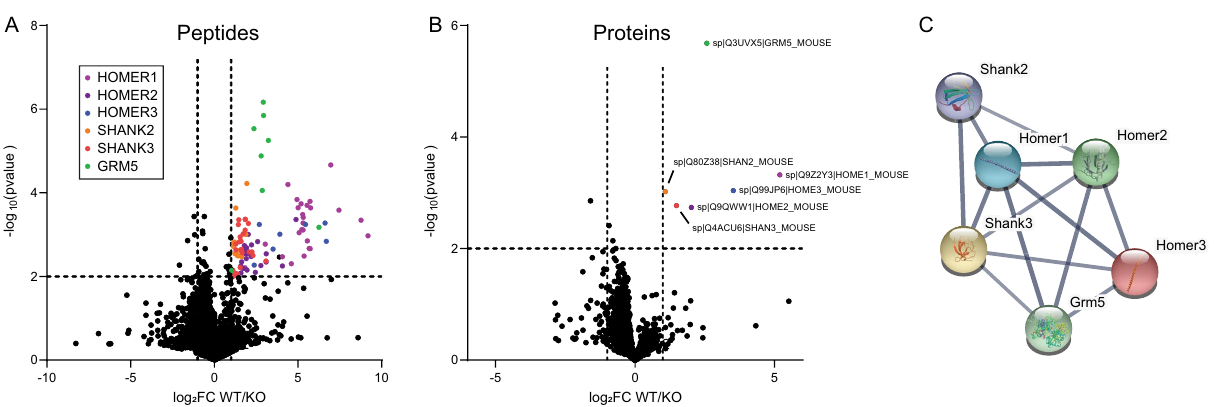
Figure 2. Co-IP’d peptides and proteins identified comparing WT vs KO in the aCSF condition. ( A ) Volcano plot showing peptides that were enriched in WT vs KO cortex. Key shows the color-coding of the peptides. ( B ) Volcano plot showing proteins that were enriched in WT vs KO cortex. Enriched proteins are labeled, and colors are consistent with ( A ). ( C ) StringDB node-edge diagram of the identified proteins highlighting the extensive known